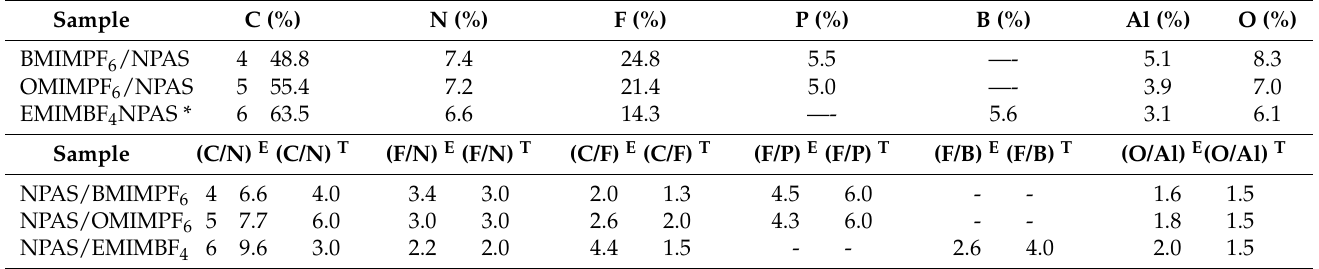
Table 2. Atomic concentration percentages of the elements found on the surfaces of the IL/NPAS samples. Experimental and theoretical (in italics) atomic concentration ratio of different